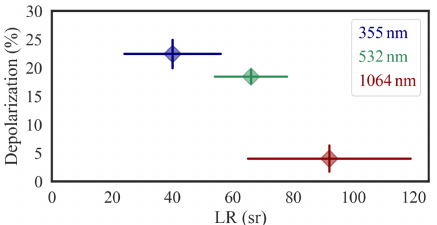
Figure 8. Intensive optical properties of the smoke particles found in the stratosphere, as measured on 22 August, in Leipzig, Ger- many. The LR mean values are plotted against the PLDR mean values, along with the corresponding errors. A typically increasing behaviour of LR for aged Canadian smoke is observed at 355 and 532nm, while for the PLDR the effect is the opposite: the surpris- ingly large, layer-integrated mean values drop from the UV to the near-IR